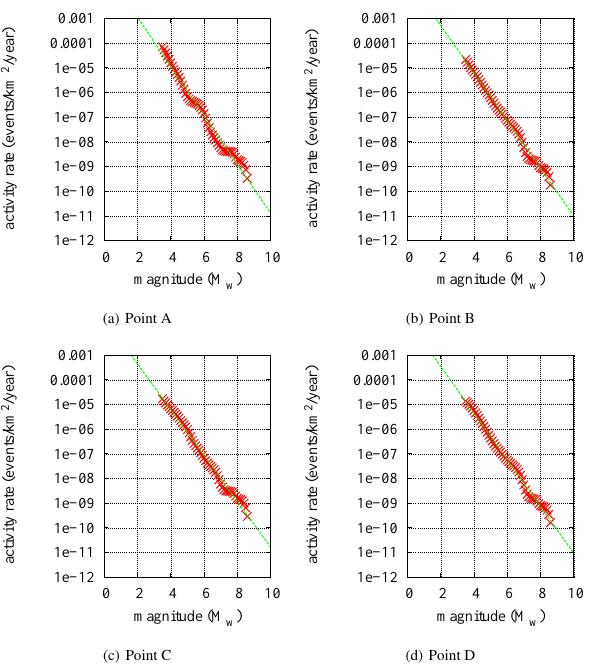
Fig. 7. Activity for each of the four locations identified in Figure 6: (a) point A; (b) point B; (c) point C; (d) point D. The relation is Figure 7. Activity for each of the four locations identified in Fig. 6: approximately straight. (a) point A, (b) point B, (c) point C, and (d) point D. The relation is approximately straight.